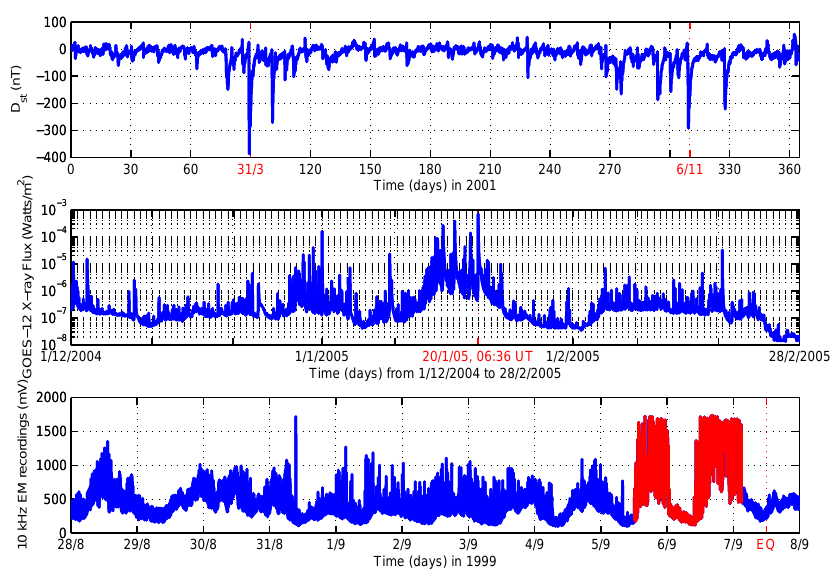
Fig. 1. D st time series (upper panel). The 31 March and 6 November 2001 magnetic storms are marked with red. GOES-12 5-min averages X-ray flux, X l (1–8 Angstrom) time series (middle panel). The 20 January 2005 solar flare is marked with red. Electromagnetic time series recorded at 10 kHz (lower panel). The pre-seismic EM emissions are shown in red. The 7 September 1999 Athens earthquake is marked with red.